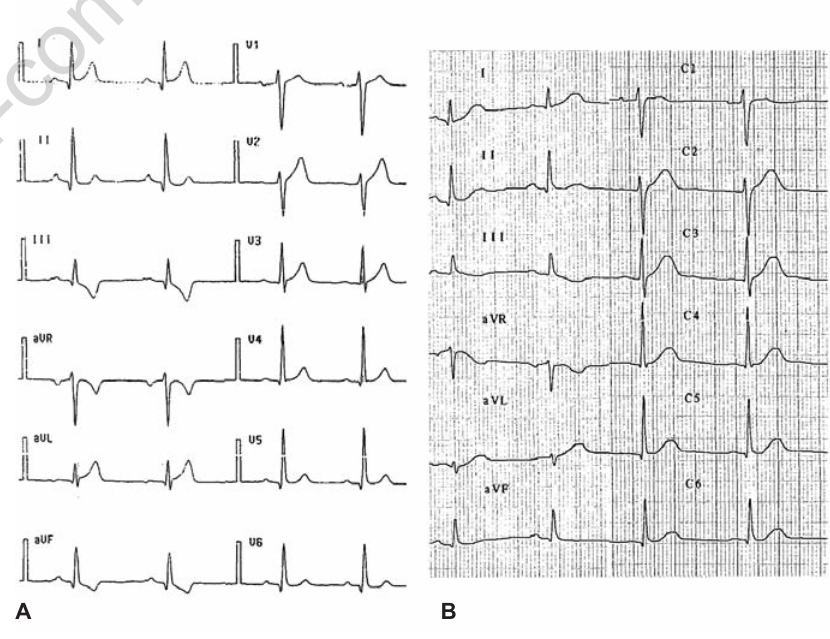
Figure 1. Unknown genotype. Male, 29 years old. A) Basal electrocardiogram (ECG): QT 300 ms, QTc 344 ms, QT/QTp 82%. B) ECG recorded following amiodarone: QT